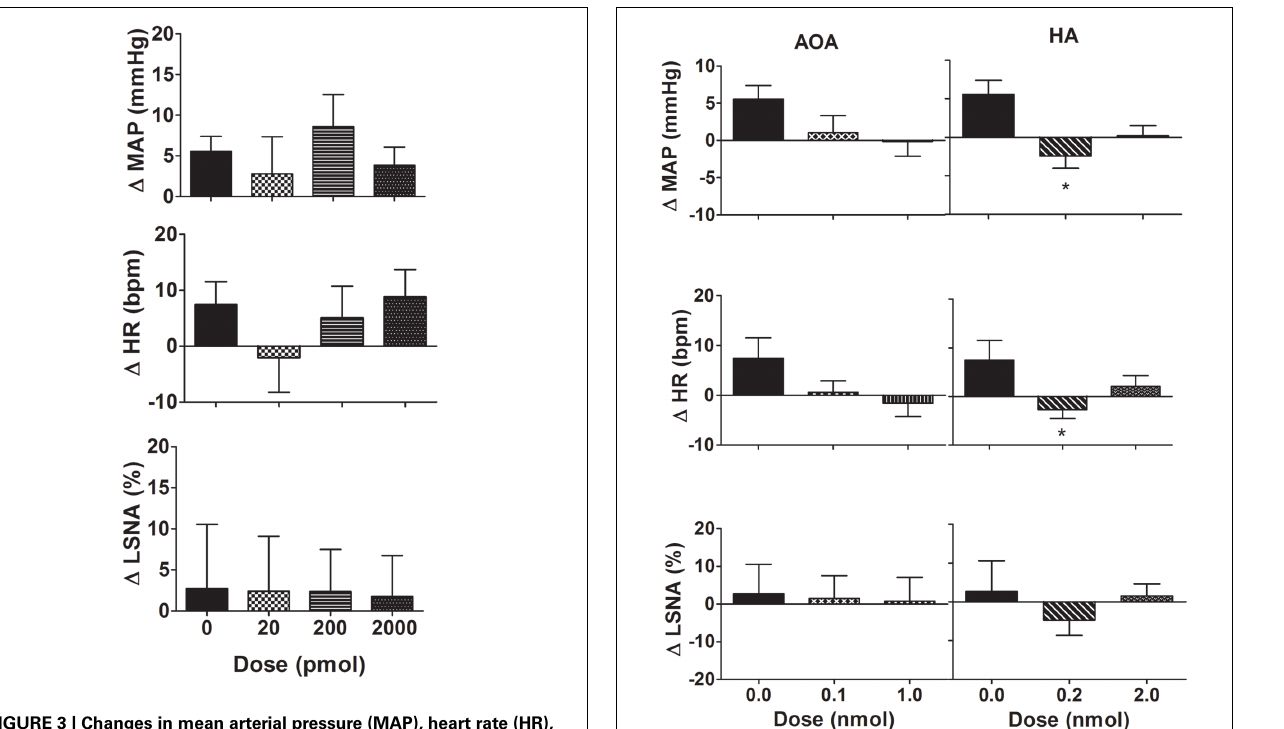
FIGURE 3 | Changes in mean arterial pressure (MAP), heart rate (HR), and lumbar sympathetic nerve activity (LSNA) following vehicle ( n = 14 for MAP and HR and n = 7 for LSNA) and the H 2 S donor, NaHS (20–2000pmol/side; n = 6 for MAP and HR and n = 5 for LSNA) microinjected into the hypothalamic paraventricular nucleus inWKY rats. Different shaded bars represent a different dose of NaHS as indicated.